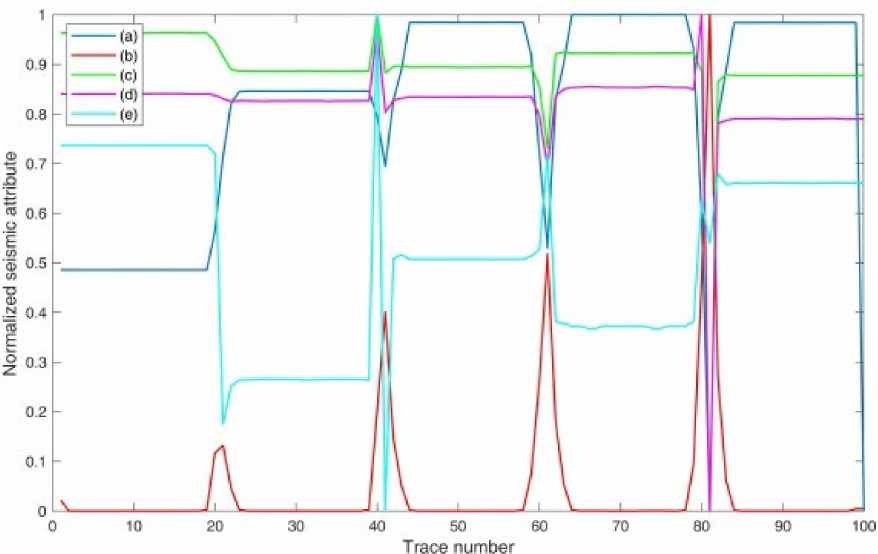
Figure 5. Normalization of the seismic attributes of the noise-free model: ( a ) instantaneous amplitude attribute; ( b ) waveform difference attribute; ( c ) instantaneous frequency attribute; ( d ) frequency bandwidth attribute; and ( e ) attenuation coefficient